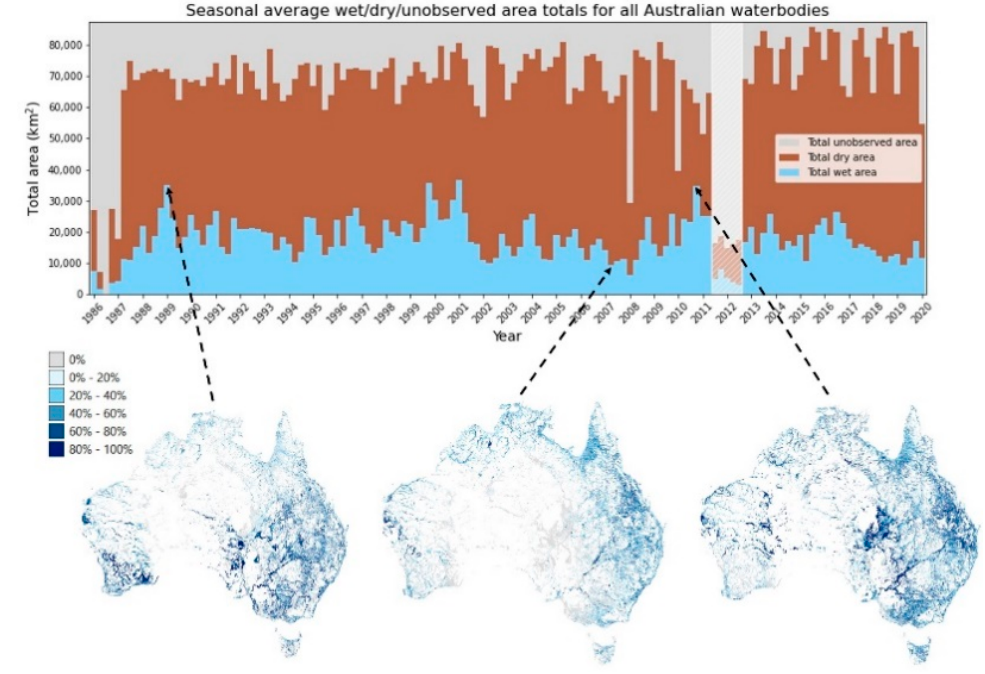
having at least 50% of the waterbody area wet. Note that this metric indicates an approximate con-